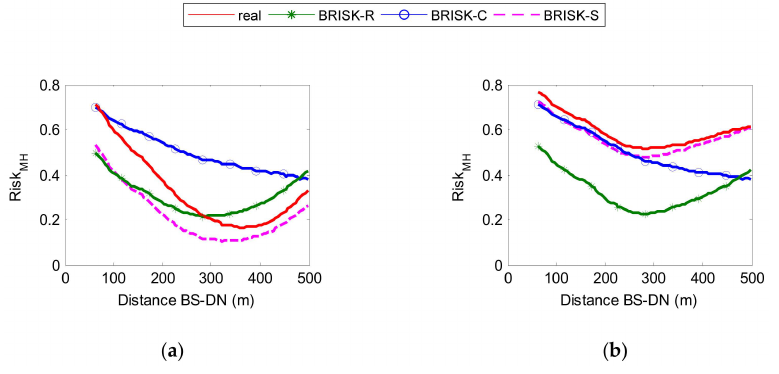
Figure 15. Real and estimated risk of selecting MH as a function of the distance between DN and